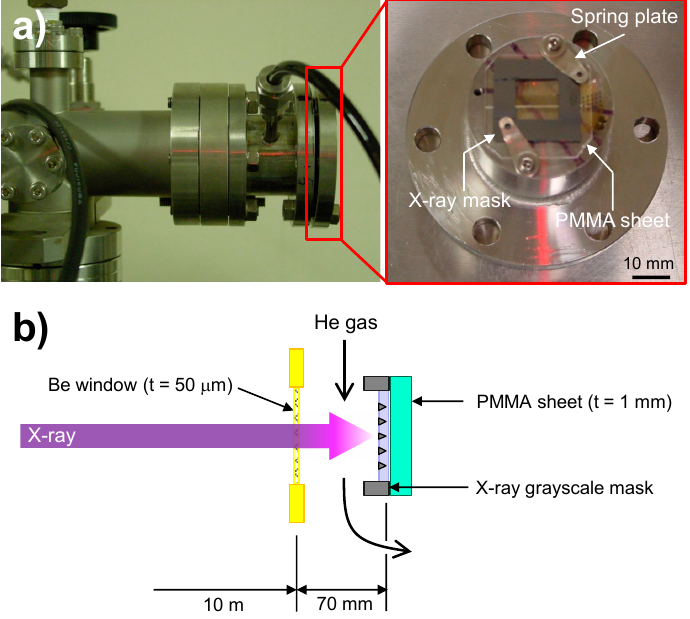
Figure 5. ( a ) Photographs of the end station of the beamline BL-4 (left) and exposure stage (right); ( b ) Cross-sectional schematic view of the end station of the beamline BL-4 during the X-ray